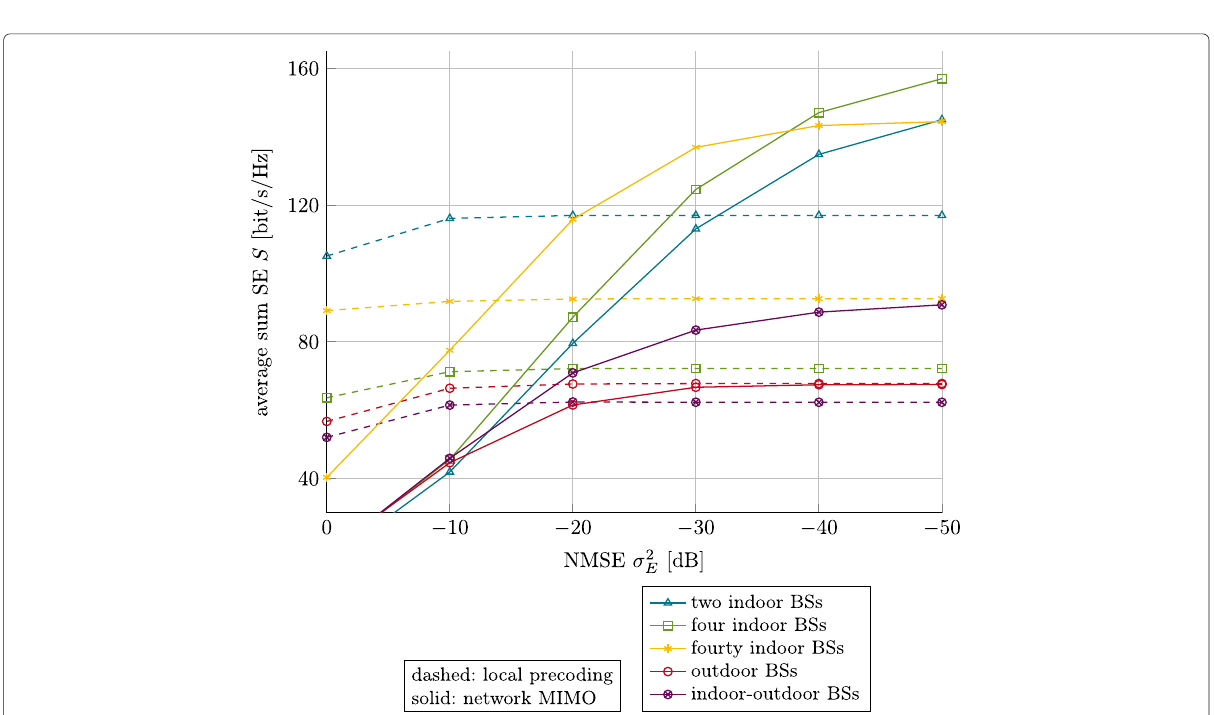
Fig. 6 Fairness study. Jain’s fairness index for 256 QAM and mercury/water-filling